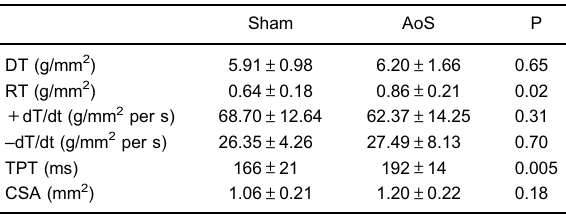
Table 4. Basal isometric contraction of animals submitted to simulated surgery (Sham) and animals submitted to aortic stenosis surgery (AoS).